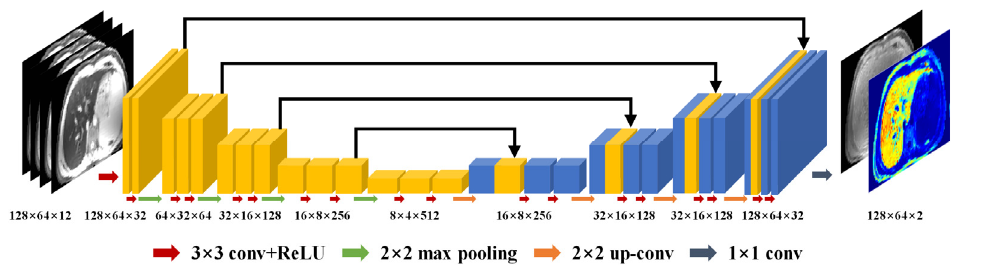
Figure 3. The architecture of the mapping network. The yellow and blue blocks are feature maps in the encoder and decoder,